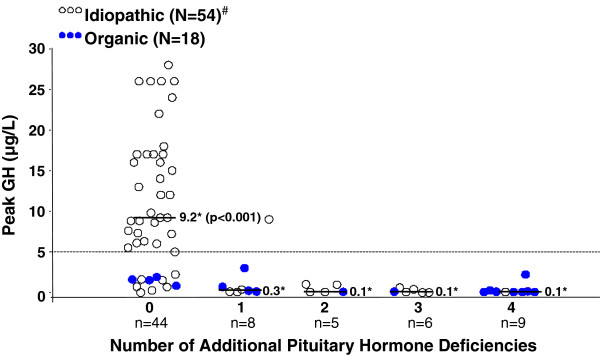
Peak GH response according to number of additional pituitary hormone deficiencies (PHD). Horizontal lines represent the median values of the peak stimulated GH concentrations for patients with 0, 1, 2, 3, and 4 additional PHDs; *p < 0.0001 for comparison of medians for the group with isolated GH deficiency (no additional PHDs) vs. all others. See “Results” for listing of stimulation tests used. #To avoid compressing the vertical axis, 1 GH value of 57 μg/L (idiopathic patient) is not shown. GH = growth hormone; N = total number of patients in each category (organic vs. idiopathic); n = number of patients in each subgroup.